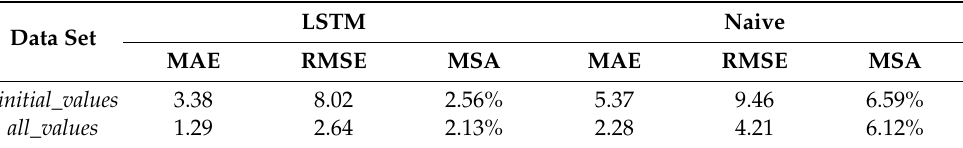
Table 2. Metrics of LSTM and Naive Time